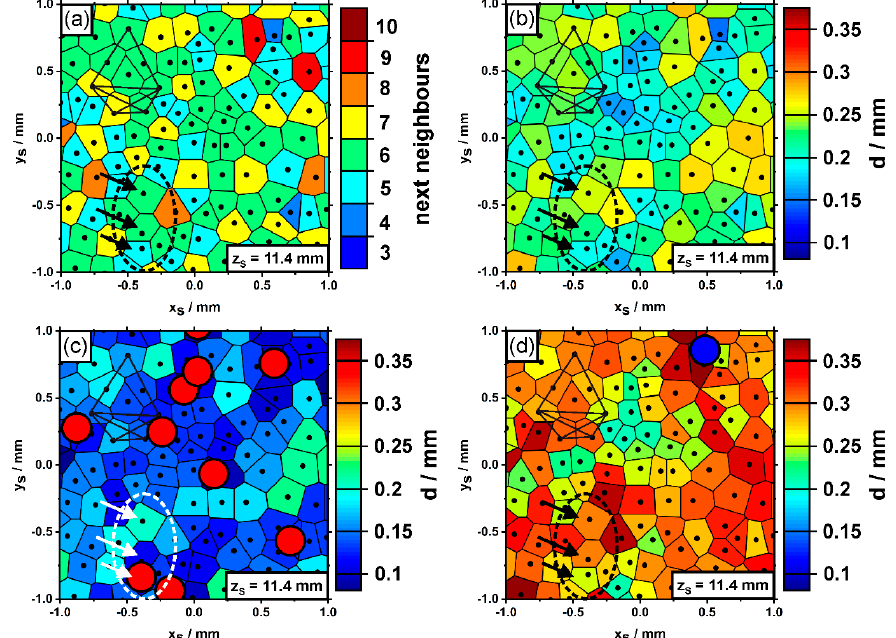
Figure 12. Voronoi tessellation plots highlighting ( a ) the numbers of nearest neighbors, ( b ) average, ( c ) minimum and ( d ) maximum primary dendrite arm spacings. The red/blue circles indicate microstructural changes within a growth step of ≈ 1mm. Red circles show positions where dendrites were eliminated by competitive growth. The blue circle shows a dendrite that has newly formed by branching. The arrows mark three misaligned dendrites. Same sample region as previously considered in Figures 5, 8 and